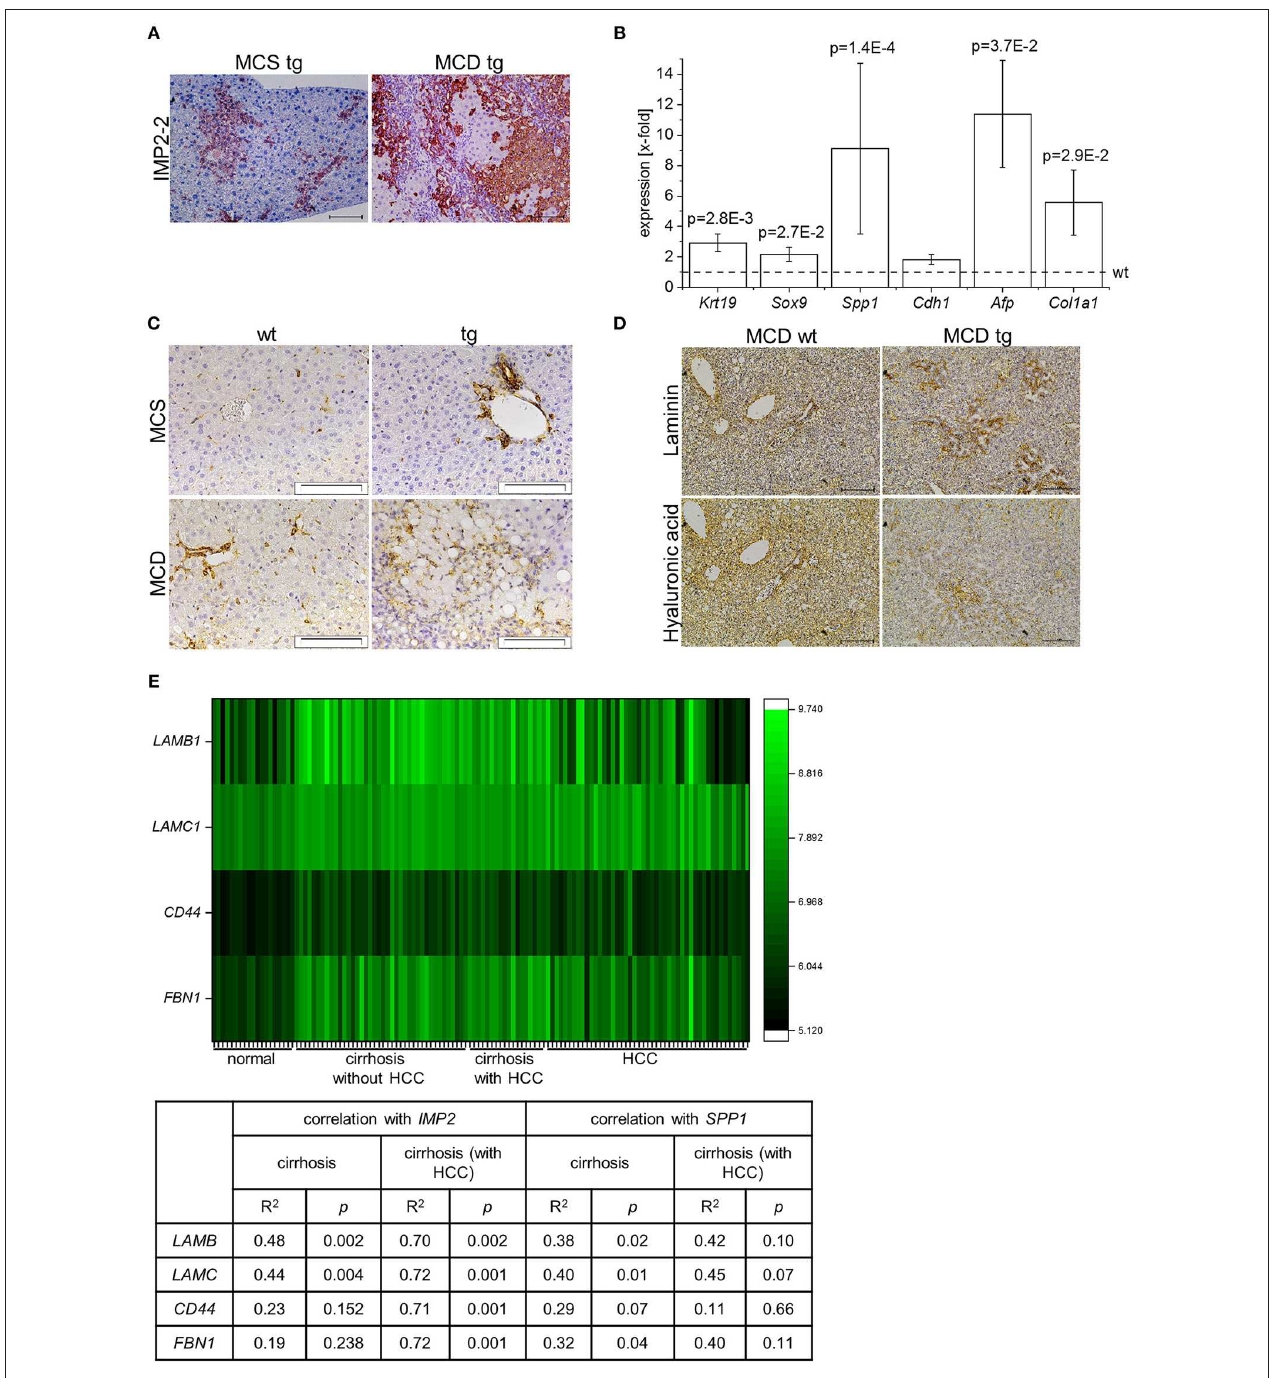
FIGURE 4 | IMP2 -2 expression correlates with the expression of extracellular matrix components. (A) Representative images of IMP2 staining in tg mice on MCS or MCD diet for 4 weeks (scale bars: 100 µ m). (B) Krt19 , Sox9 , Spp1 , Cdh1 , Afp, Col1a1 mRNA expression levels of 4 weeks MCD-fed IMP2-2 tg mice ( n = 12), shown as x-fold of wild-types ( n = 12; indicated by dashed line). 18S was used as a housekeeping gene. Statistical significance compared to wt was determined by Mann-Whitney U -test or Welch’s t -test. (C) Representative immunohistochemical staining for α -SMA in wt and tg mice fed a MCD or a MCS control diet for 4 weeks (MCS: n = 10 per genotype, MCD: n = 12 per genotype; scale bars: 50 µ m). (D) Representative image of an area of DR stained for laminin (upper panel) and hyaluronic acid (lower panel) in wt and tg mice fed a MCD diet for 4 weeks ( n = 12 per genotype; scale bars: 100 µ m). (E) Heatmap shows expression of LAMB1 , LAMC1 , CD44 and FBN1 in human samples of normal liver tissue ( n = 19), cirrhotic tissue ( n = 41), cirrhotic tissue of HCC-livers ( n = 17), and HCC tissue ( n = 48) (GSE14323). The table shows a correlation analysis of IMP2 and SPP1 with LAMB1 , LAMC1 , CD44, and FBN1 in human samples of cirrhotic tissue ( n = 41) and cirrhotic tissue of HCC-livers ( n = 17) (GSE14323). The correlation coefficient was calculated by Pearson correlation.